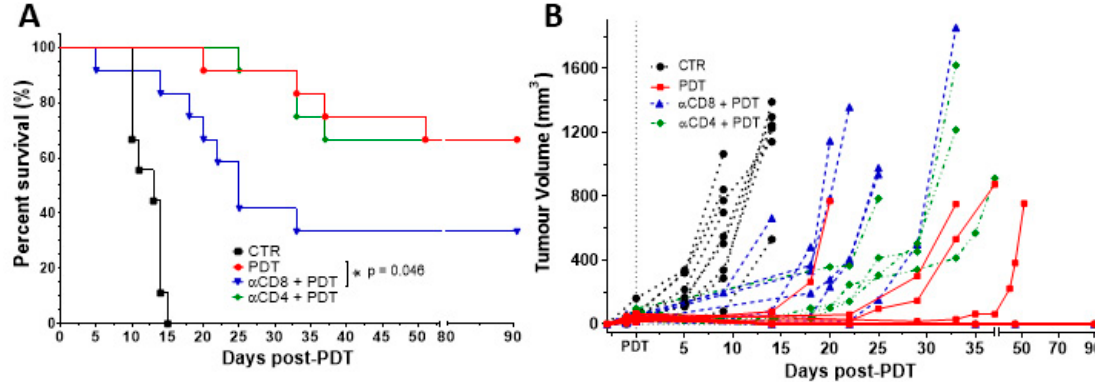
Figure 5. Tumour eradication by redaporfin-PDT is dependent on CD8 + T cells but not on CD4 + T cells. ( A ) Survival curve of mice bearing CT26.WT tumours treated with redaporfin-PDT in normal conditions or upon depletion of CD4 + or CD8 + T cells. ( B ) Tumour growth represented individually for each mouse (9–12 mice per group). Survival curve statistics by LogRank (Mantel–Cox) test. No symbol: p > 0.05; * p < 0.05. symbol: p > 0.05; * p <